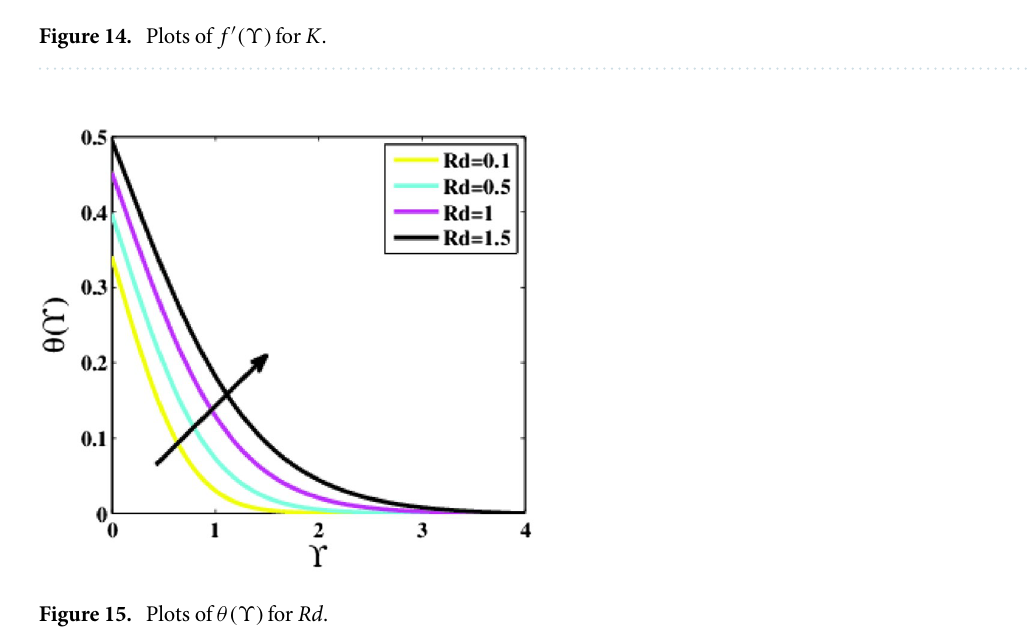
Figure 14. Plots of f